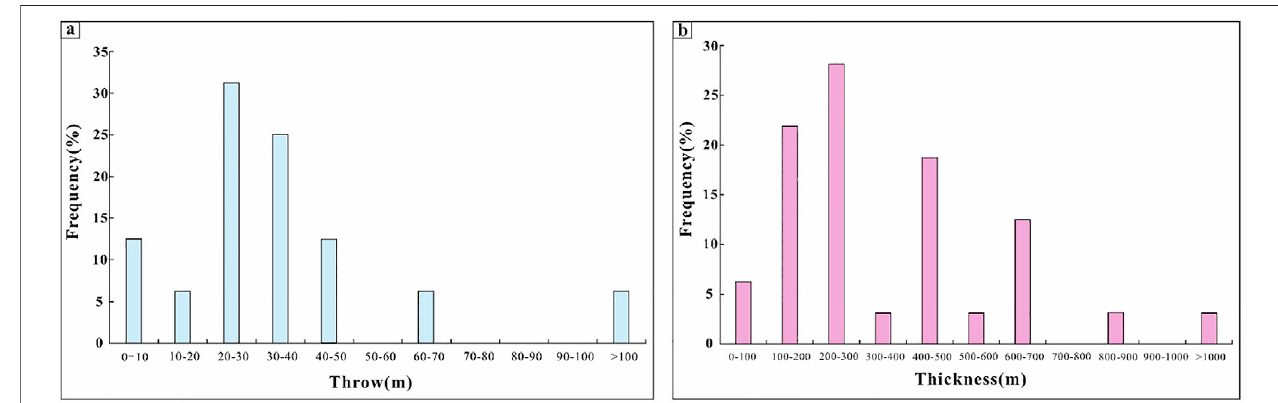
FIGURE3|(A) FrequencyofthethrowofpolygonalfaultsoftheglobalPFscase; (B) FrequencyofthethicknessofsolelayerwithpolygonalfaultsoftheglobalPFs case.